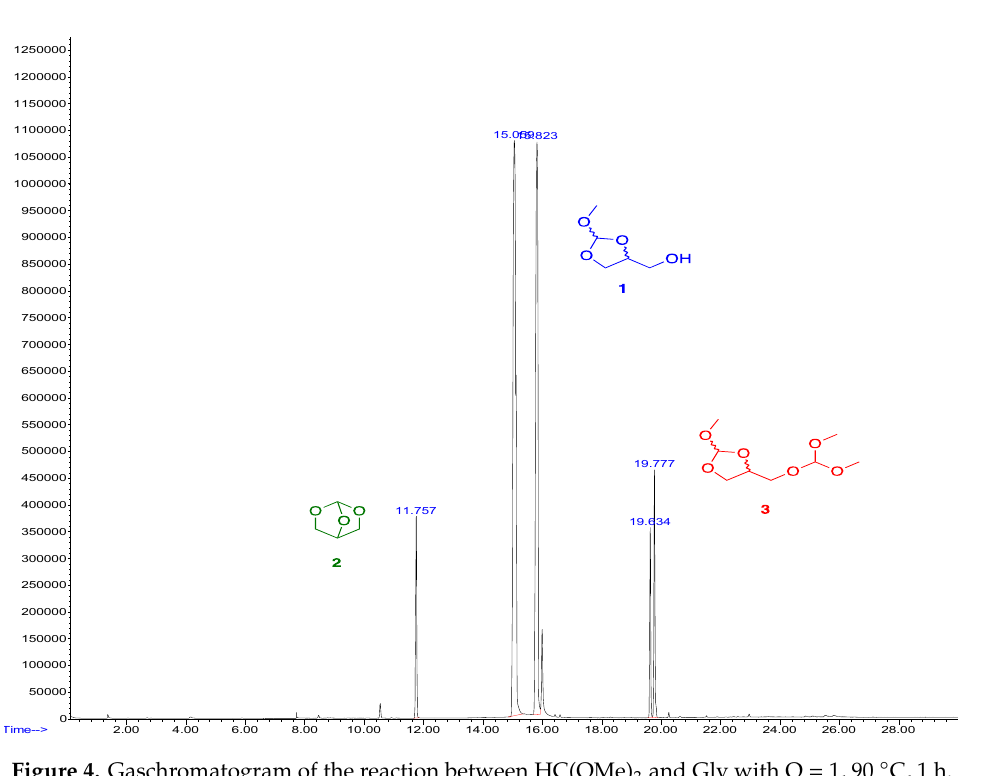
Figure 3. Reaction of Gly with HC(OMe) 3 .